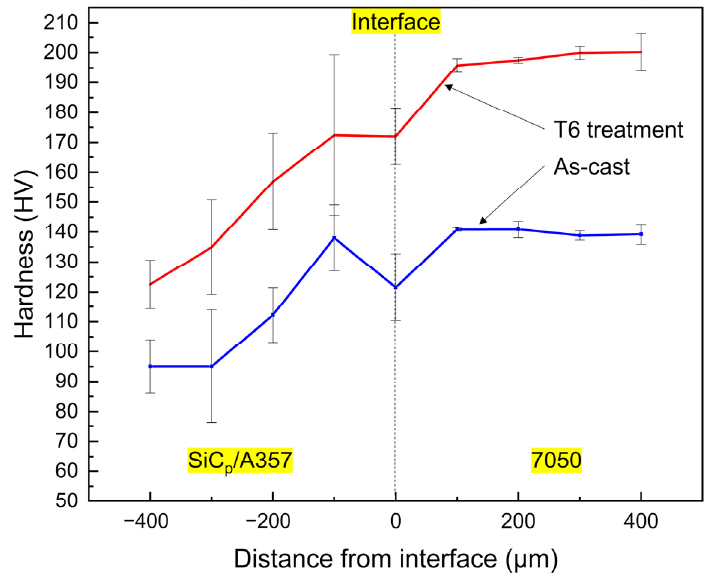
Figure 19. Variation of hardness across the solid–liquid bonding